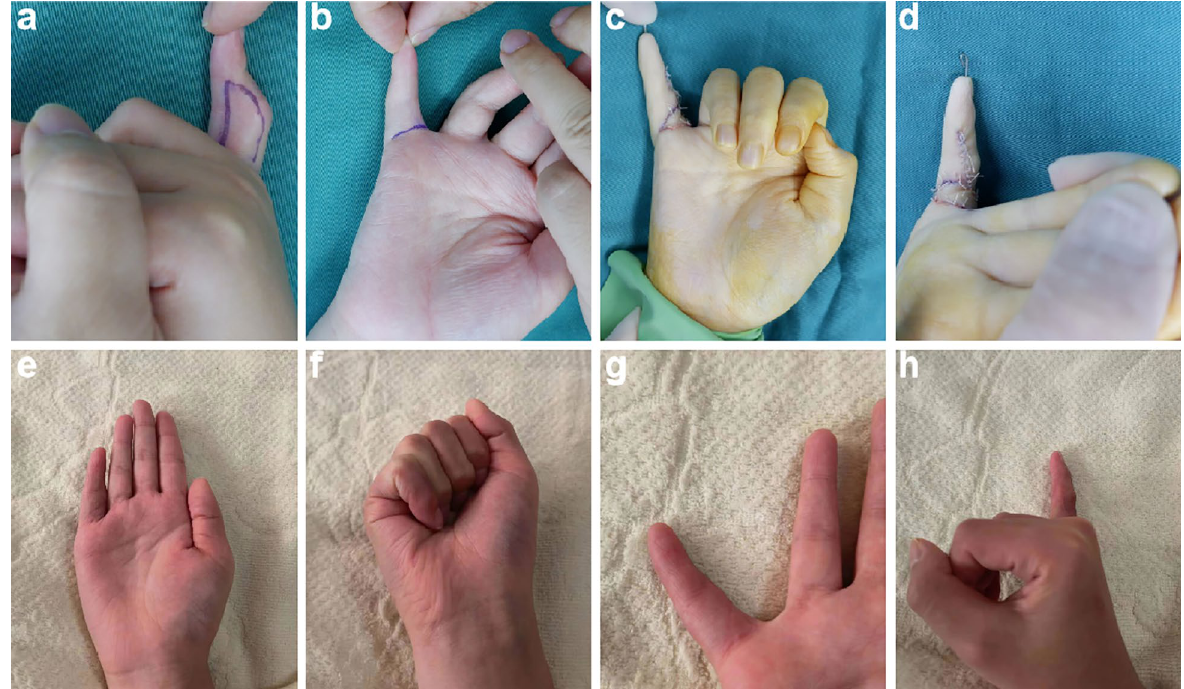
Figure 1. Representative images of camptodactyly seen in an 11-year-old patient. ( a ) The preoperative design of flap: the flap is designed on the radial wall of the little finger. ( b ) The palmar skin incision. ( c ) The flap was rotated 90° to completely cover the palmar skin defect. ( d ) Suture the surplus skin on the dorsal side of finger to the palmar side of skin. ( e ) The extension of the proximal interphalangeal (PIP) joint 6 months post-operation. ( f ) The flexion of the PIP joint 6 months post-operation. ( g ) The surgical incision appeared natural and had no visible scar. ( h ) The incision on the radial wall of finger showed good healing.